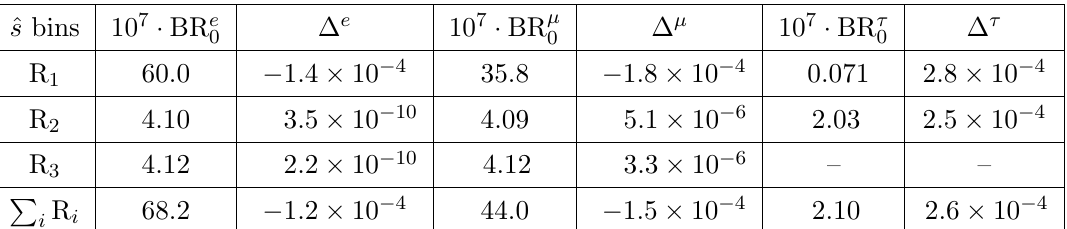
(1 + (cid:1) ‘ ) for ‘ = e; (cid:22); (cid:28) , and (cid:1) ‘ includes the 0